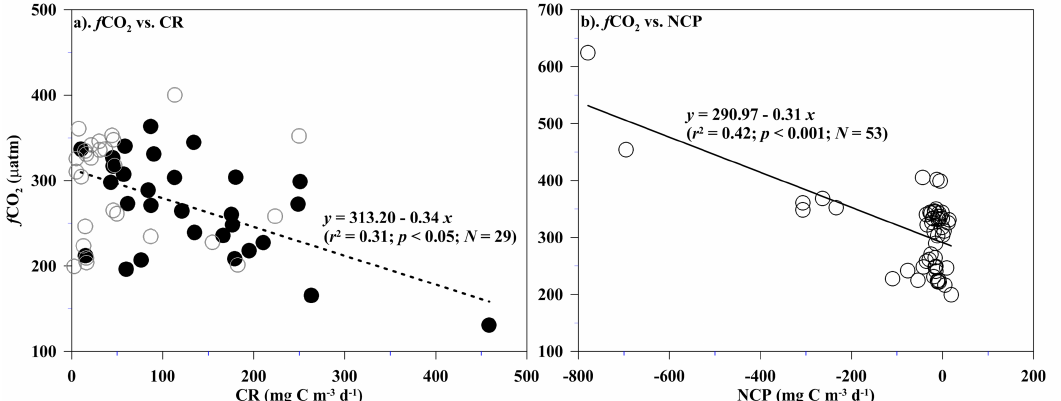
Fig. 8. Relationships between fugacity of CO 2 ( f CO 2 ) vs. (a) plankton community respiration (CR) in the surface waters and (b) net community production (NCP = PP–CR) in the spring of 2009 ( • ; dashed line) and 2010 ( (cid:13) ; solid line). Primary production was used the measured values where incubation performed. Both p and r 2 values of linear regression are also shown if statistical significance was